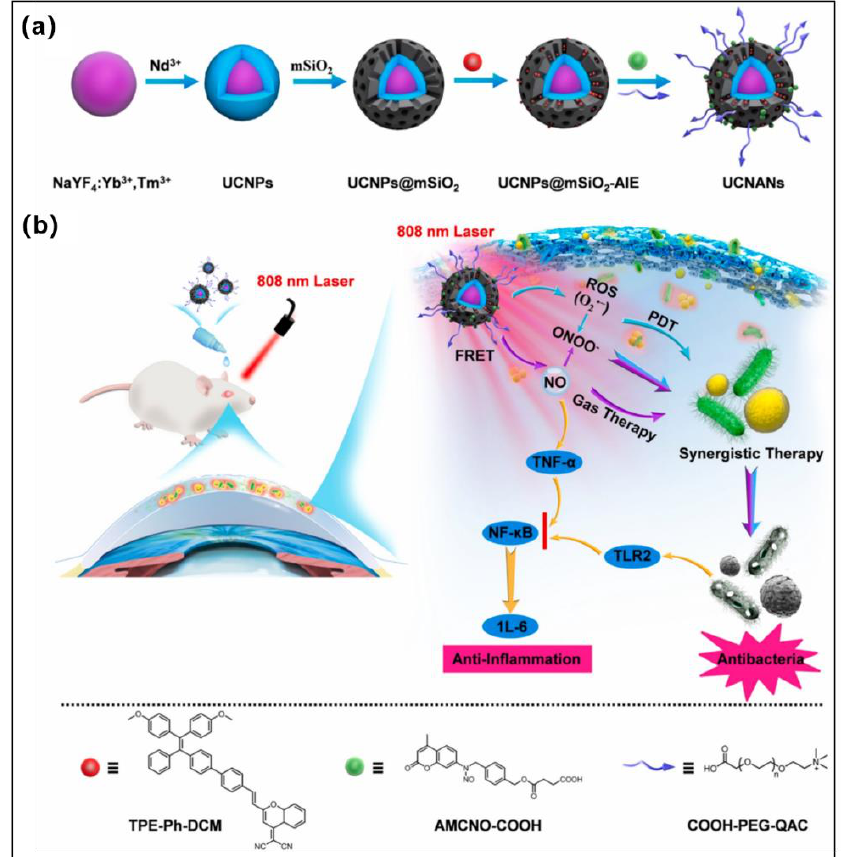
Figure 10. ( a ) Diagrammatic representation of the artificial pathway to UCNANs . ( b ) Illustration of UCNANs for synergistic type I PDT and NO gas therapy of refractory keratitis. Reprinted with permission from [113].